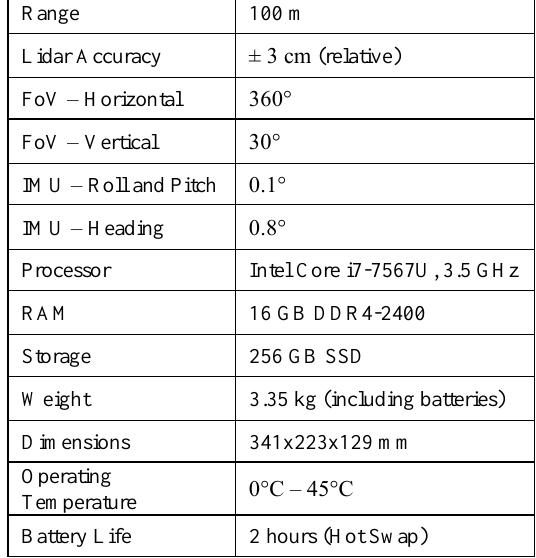
Table 1. Specifications of TORCH handheld mobile laser